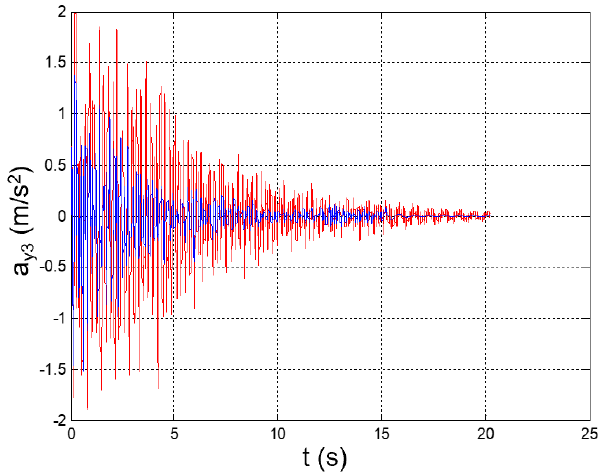
Figure 28. Seismic response, 3rd-floor acceleration (Node 47) with respect to the ground.